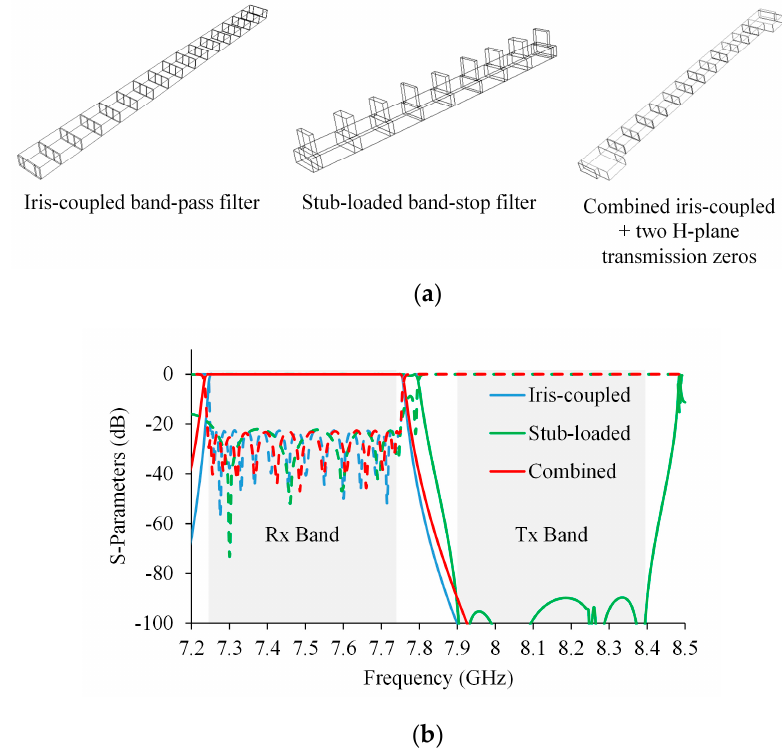
Figure 11. ( a ) Designed filter topologies for size comparisons with the proposed structure in the VSAT Rx band, ( b ) simulated transmission (solid lines) and reflection (dashed lines) results of the designed topologies.